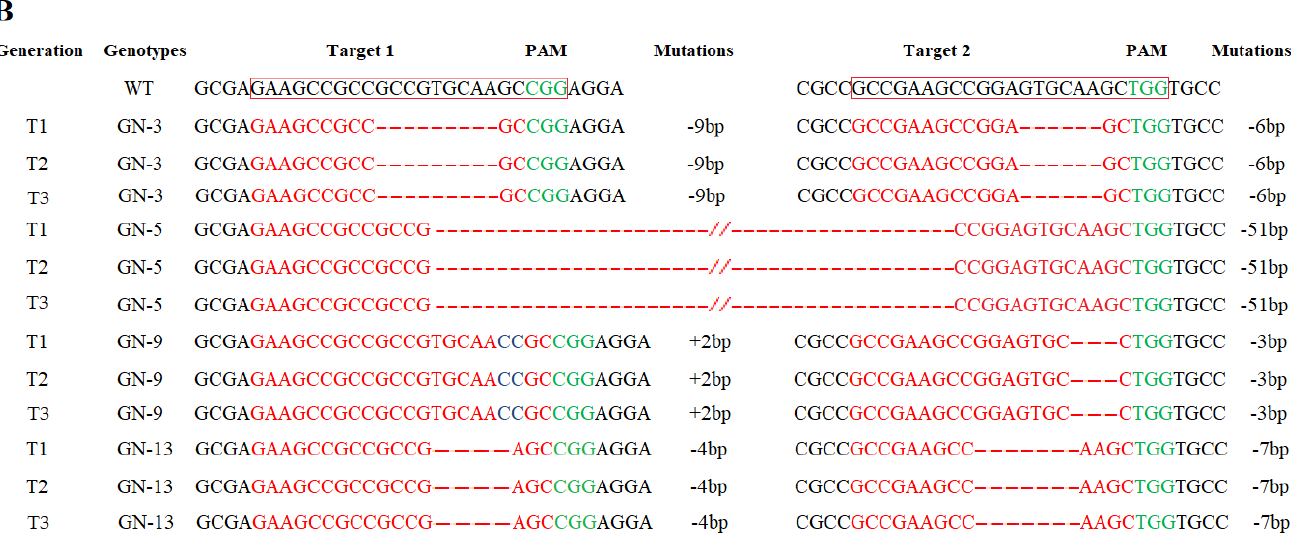
Figure 1. Detection of mutations induced by CRISPR / Cas9; ( A ) chromatograms showing the sequencing results for both the target sites in mutant lines; ( B ) inheritance of mutations in T 1 and T 2 and T 3 generations. Red hyphens and letters represent the deletions and blue letters represent insertions, respectively while the PAM sequence is highlighted in green.